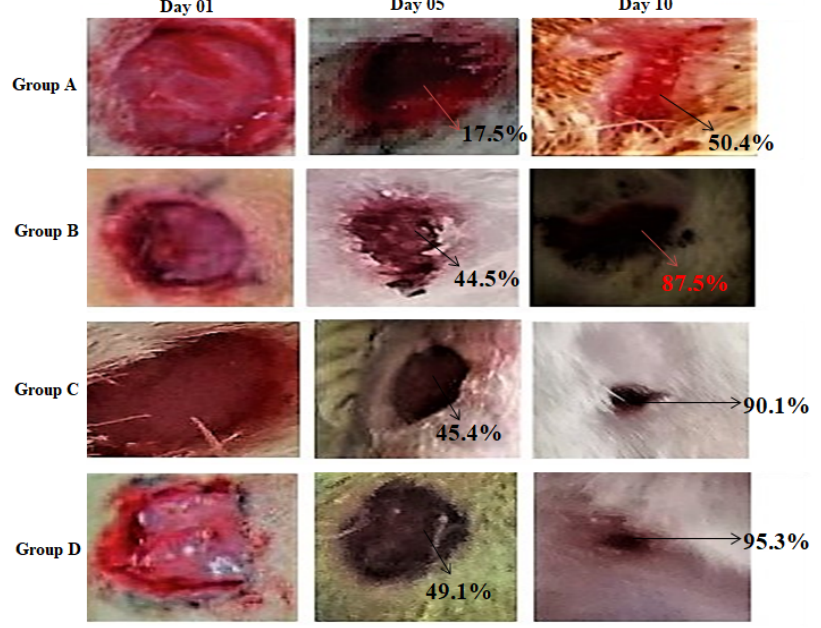
Figure 8. Representative images of wound-healing on various days.